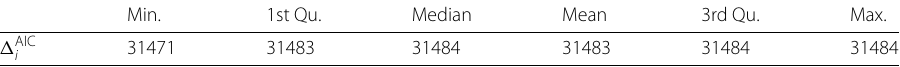
Table 3 (cid:5) AIC values from the model with the correct assignment vertices-blocks, obtained for 1000 i random assignment of vertices to the blocks, computed on the same observed graph Min. 1st Qu. Median Mean 3rd Qu.